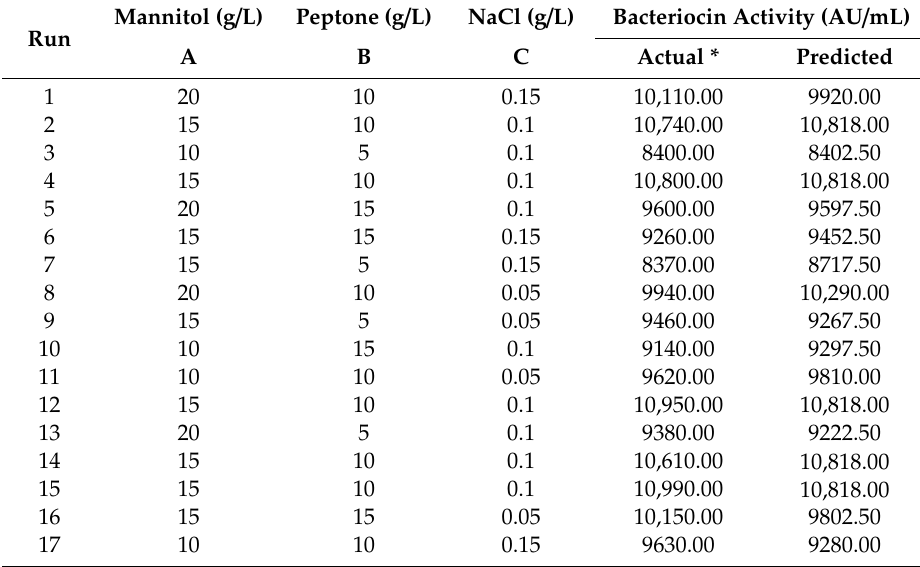
Table 2. Experimental runs and the result of the Box–Behnken experiment.